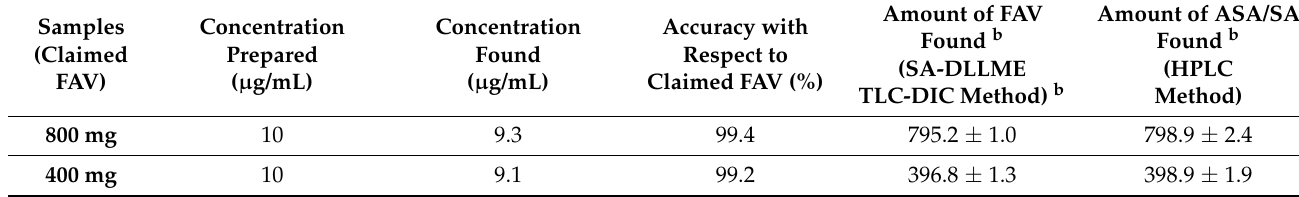
Table 7. Determination of FAV in pharmaceutical formulations ( n =